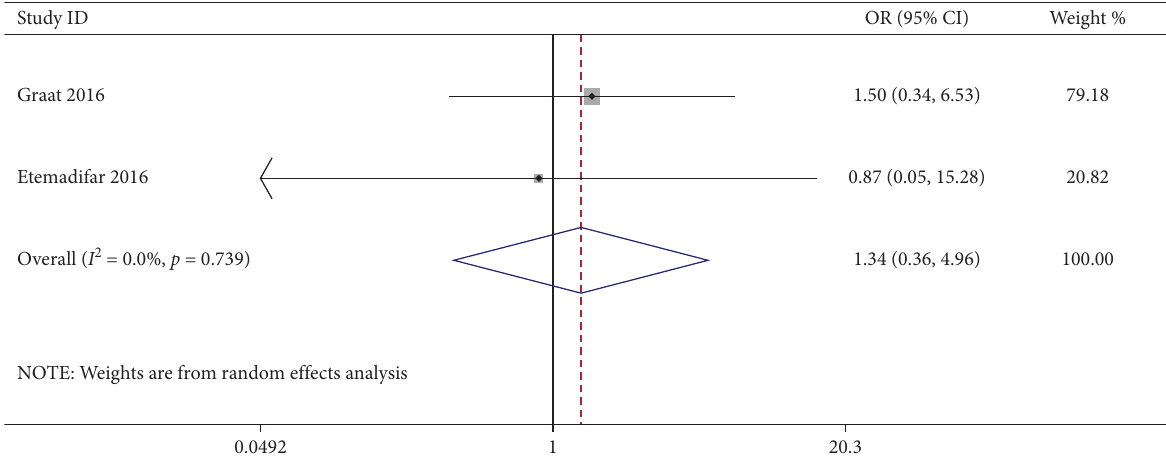
Figure 5: Comparison of proximal junctional kyphosis (PJK) incidence between the combined anterior-posterior approach and the posterior-only approach.